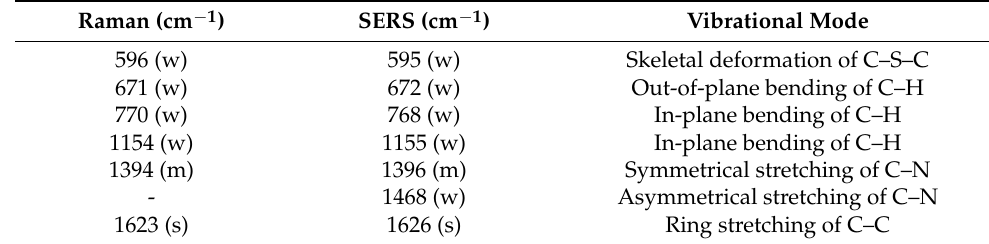
Figure 8. ( a ) Raman spectra of the MB solution with different concentrations on the Ag NPs 30 -Ag 20 -AAO substrate; ( b ) the linear relationship between the integral area of Raman intensity and the different concentrations at 1626 cm −1 in a logarithm scale. Table 2. Vibrational modes of the MB Raman characteristic peaks.